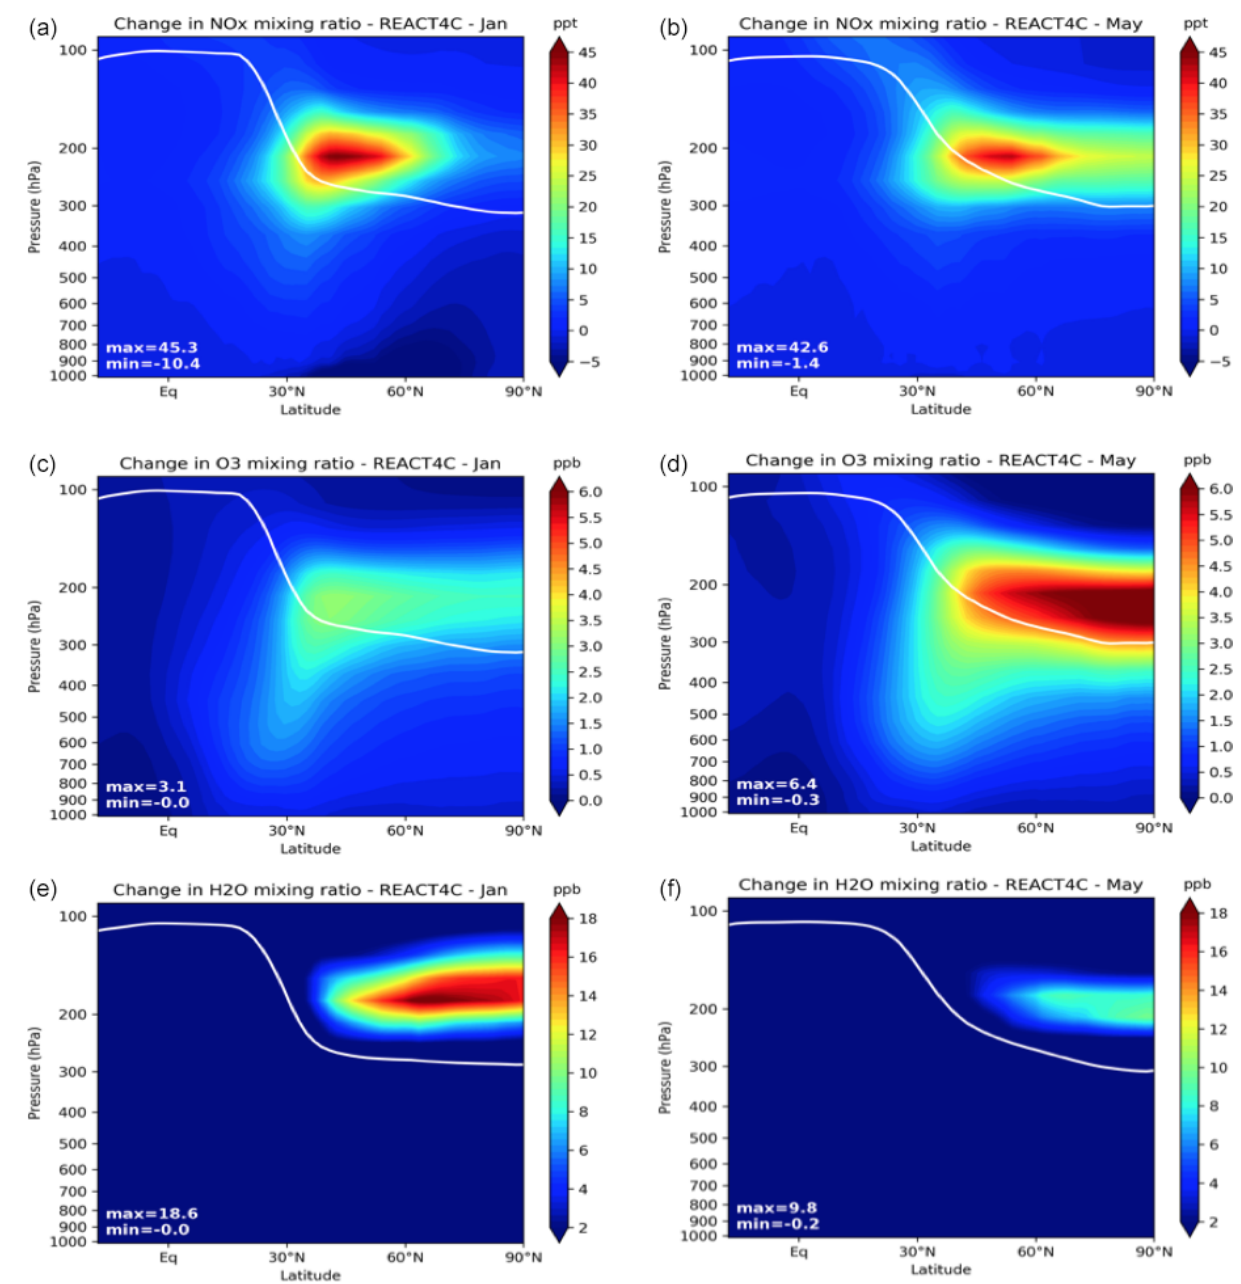
Figure 5. Zonal mean perturbations due to aircraft emissions for January (a, c, e) and May (b, d, f) of NO x (pptv), O 3 (ppbv), and H 2 O (ppbv) for the REACT4C_2006 inventory. The solid line represents the model tropopause